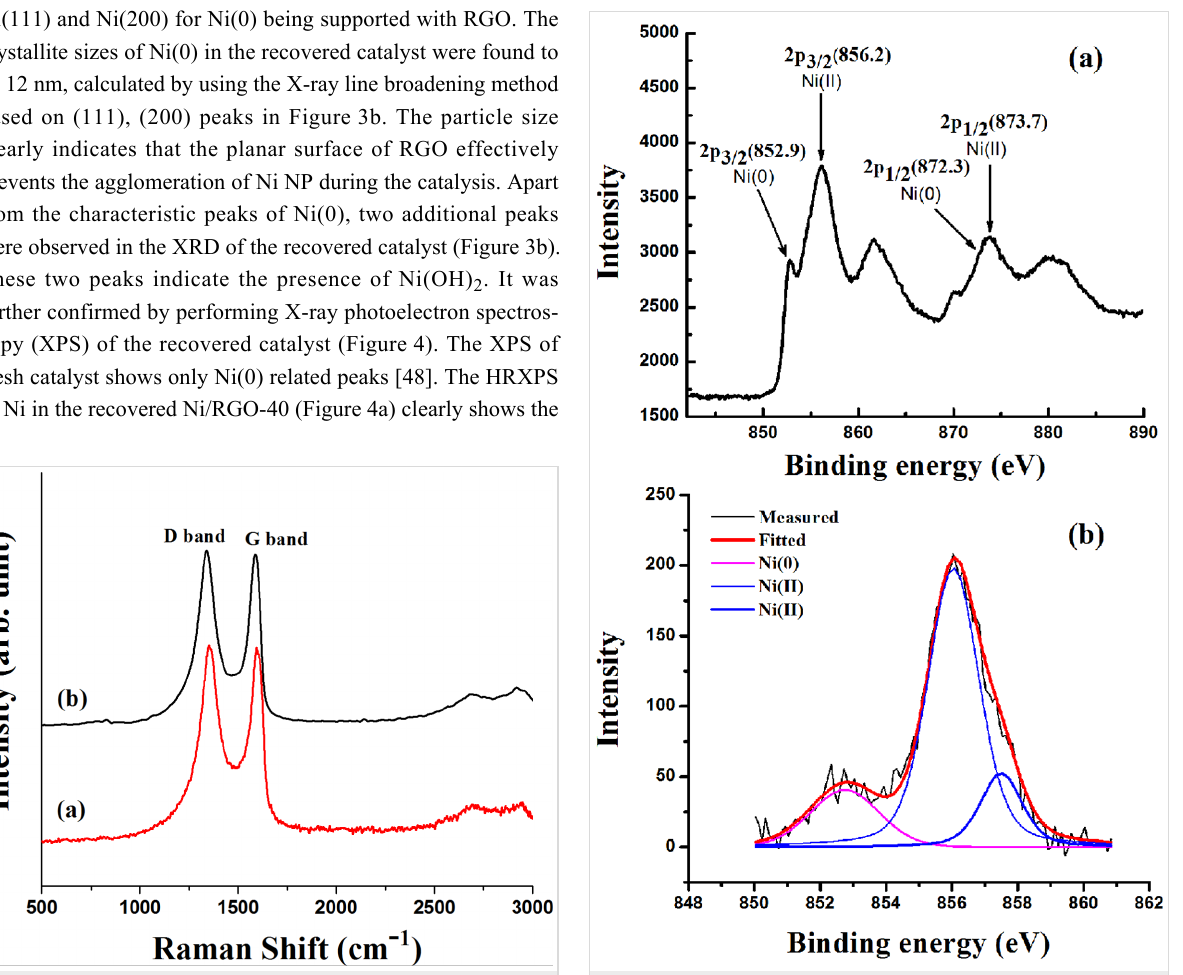
Figure 4: HRXPS of Ni in (a) Ni/RGO-40 catalyst recovered after the first cycle of the reaction. (b) Deconvoluted 2p 3/2 peak of Ni from